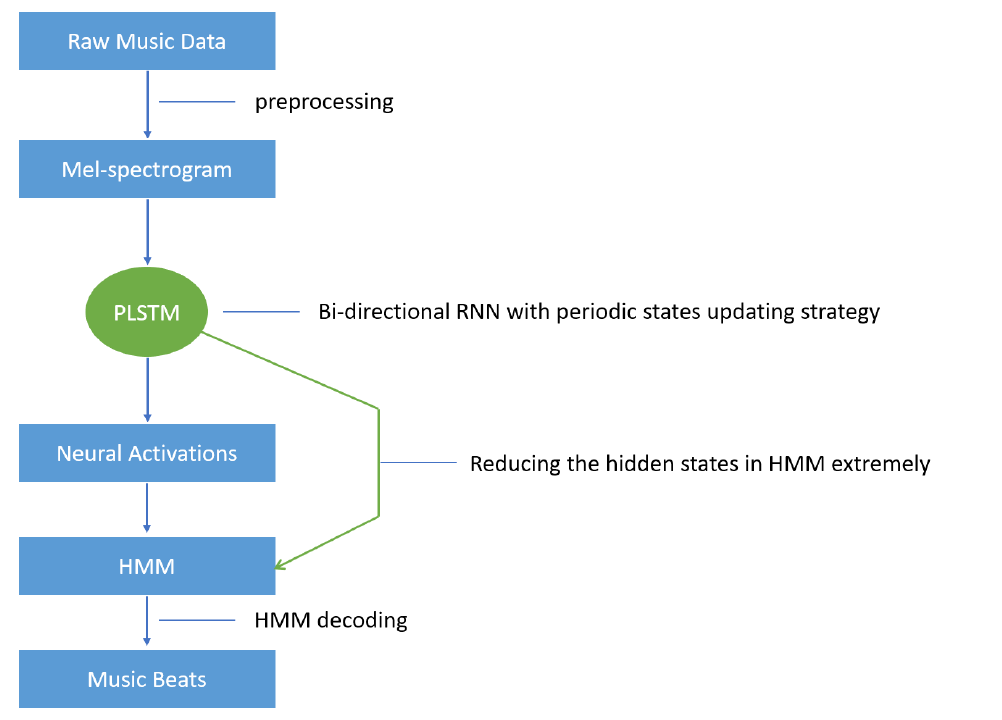
Figure 1. Data flow diagram of the proposed beat tracking